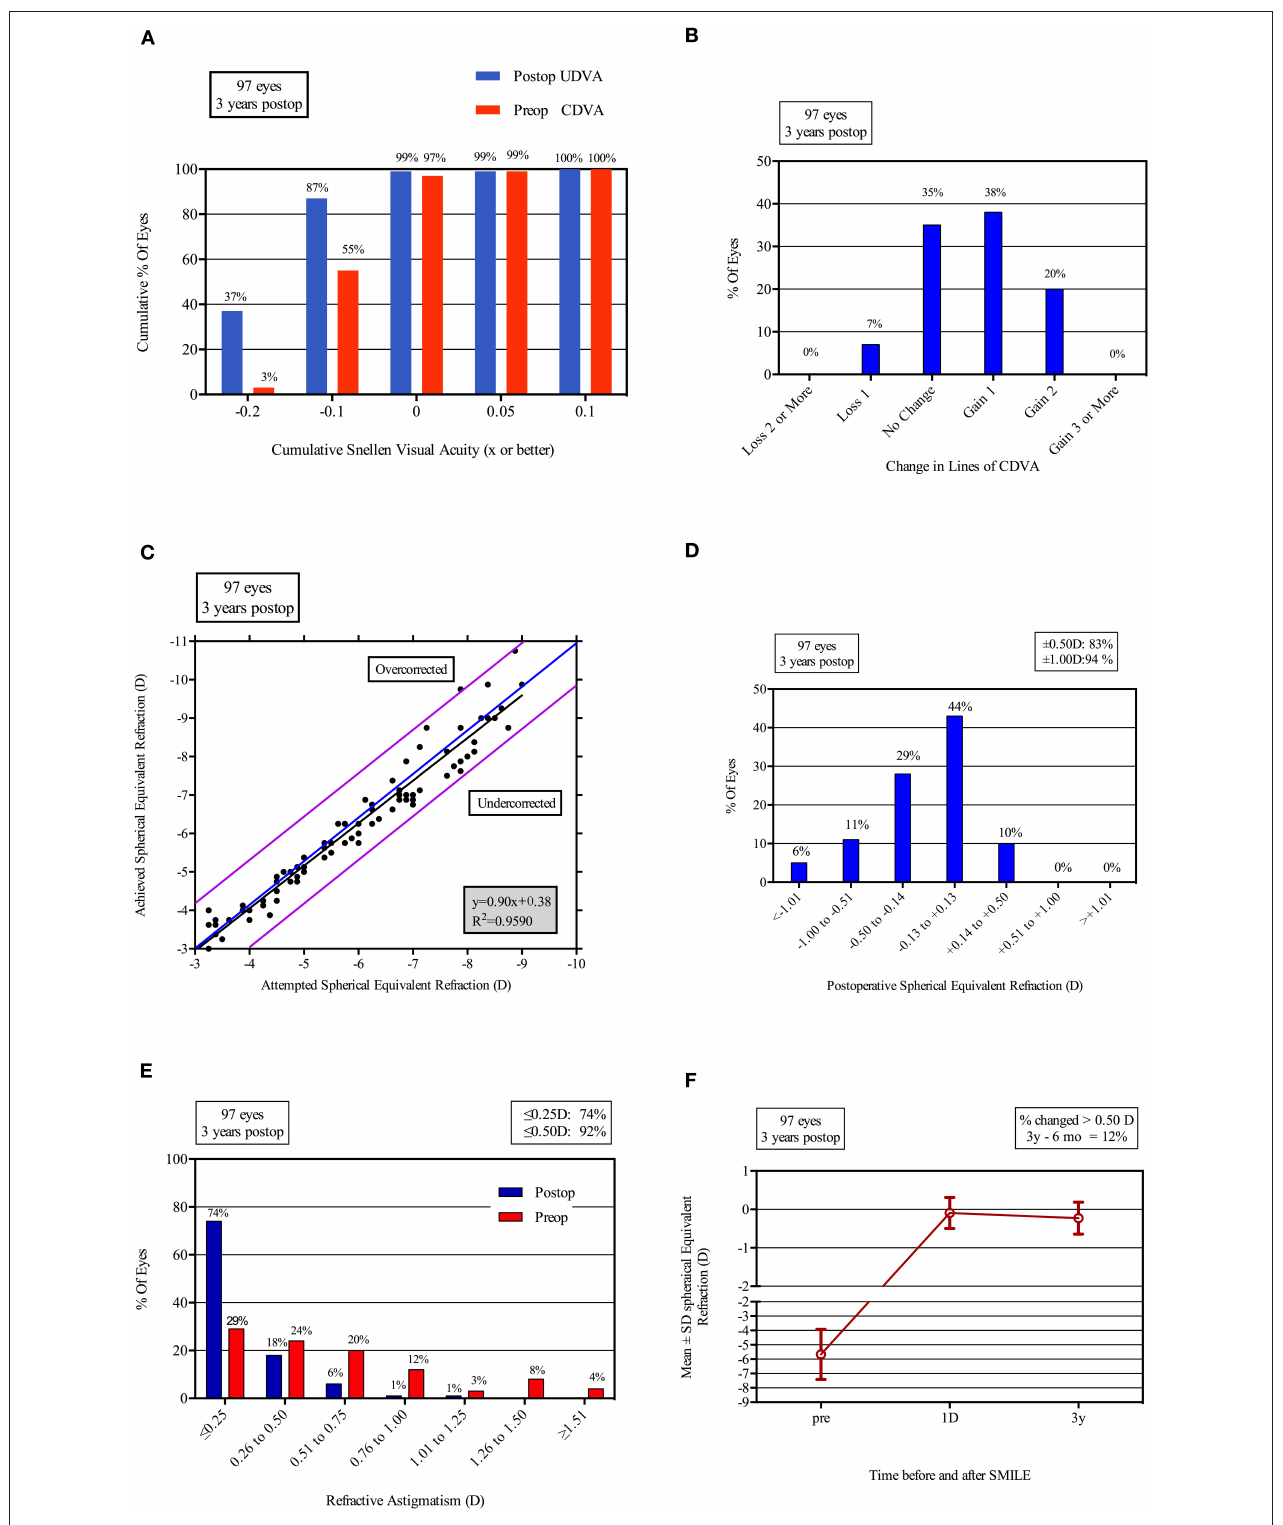
FIGURE 1 | Refractive outcomes at 3 years postoperatively in 97 eyes after SMILE. UDVA, uncorrected distance visual acuity (LogMAR); CDVA, corrected distance visual acuity (LogMAR); D, diopters; Postop, postoperative; Preop, preoperative. (A) Uncorrected distance visual acuity; (B) Change in corrected distance visual acuity; (C) Spherical equivalent attempted vs achieved; (D) Spherical equivalent refractive accuracy; (E) Refractive astigmatism; (F) Stability of spherical equivalent refraction.